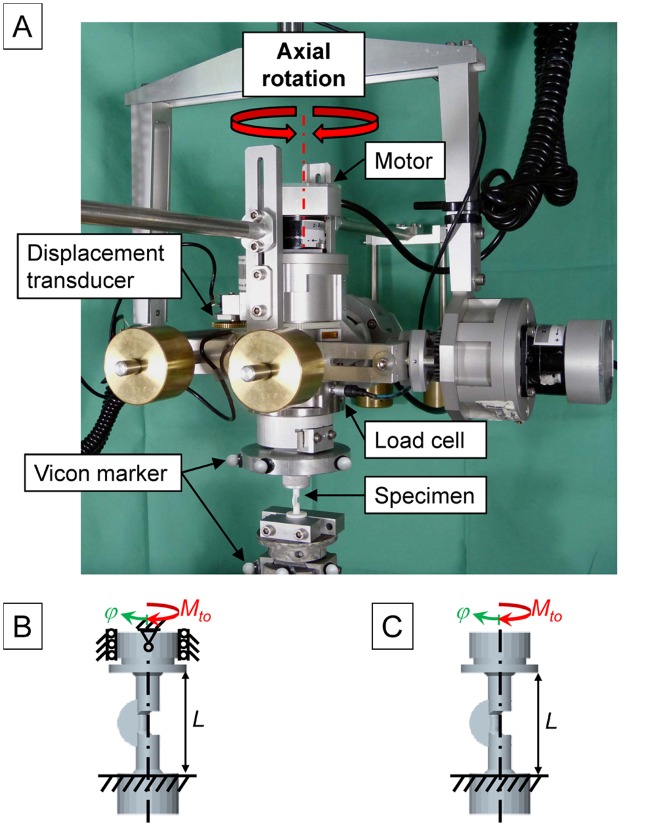
Torsional testing.A) Test set-up for torsional testing in the multi-axial flexibility testing machine. B) boundary conditions for constrained torsional testing (CT) and C) boundary conditions for the unconstrained torsional testing (UT).